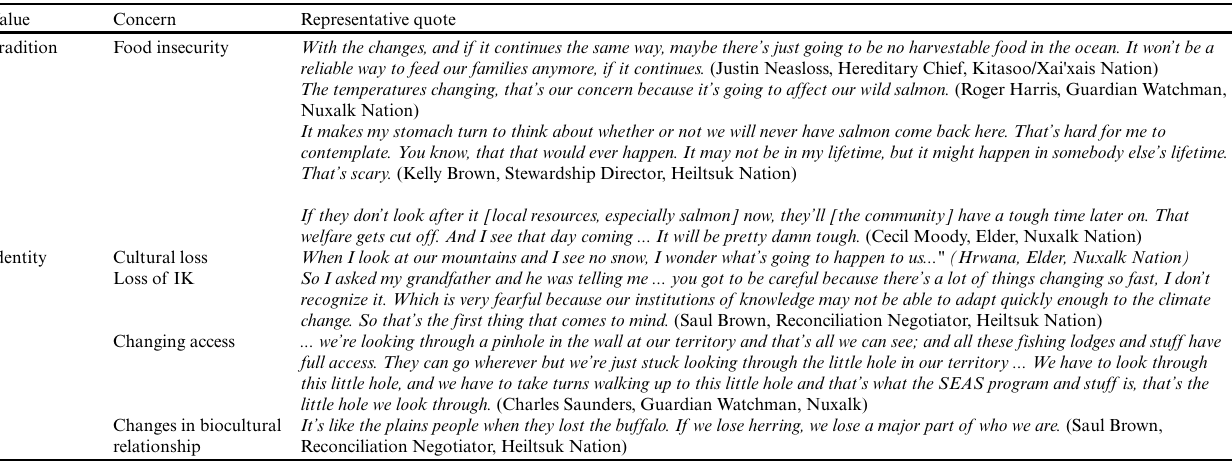
Table 4 . Perceived concerns and fears related to climate change in terms of values and ways of life. IK = Indigenous